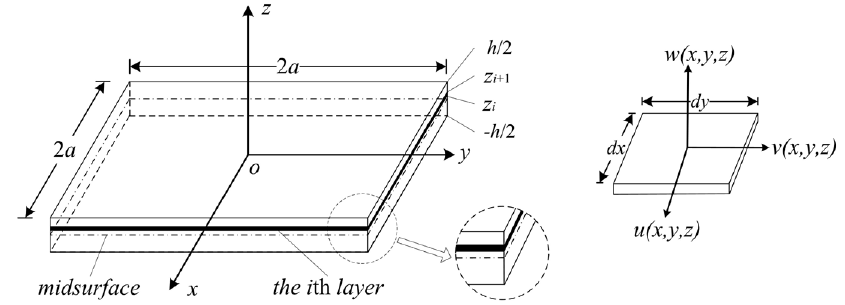
Figure 2. A schematic drawing of a multilayer CMUT membrane.